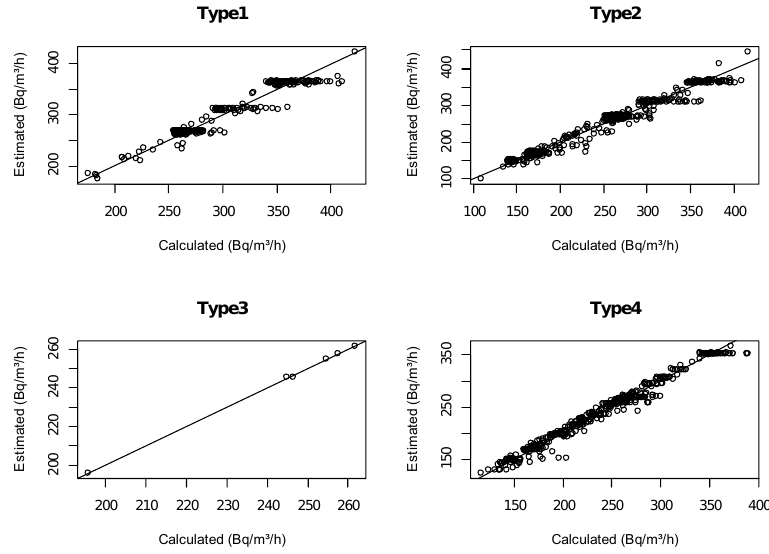
Figure 1. Comparison of calculated and estimated values of infiltration factor 𝑆 according to residence characteristics.